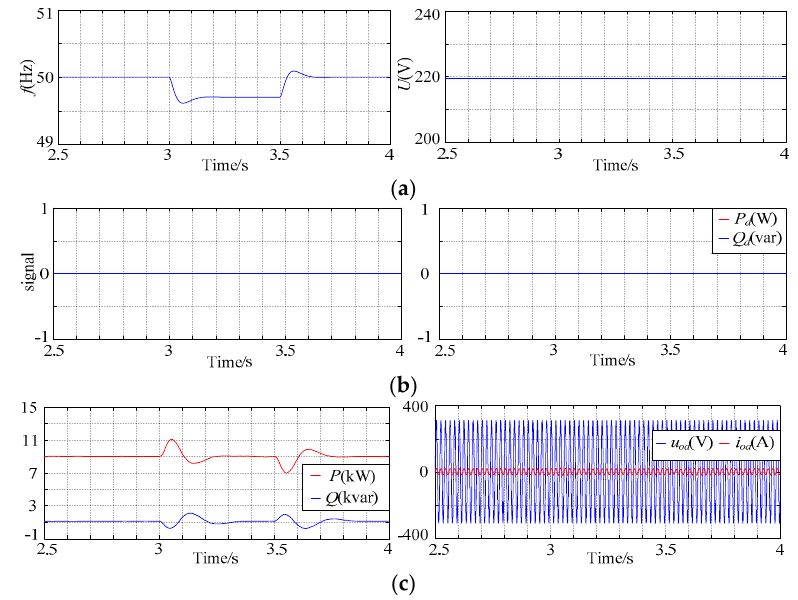
Figure 15. Islanding detection process in frequency disturbance of power grid: ( a ) The output voltage frequency and ampitude of the inverter; ( b ) The signal of islanding detection and the power disturbance; ( c ) The output power and the A phase voltage and current of inverter.